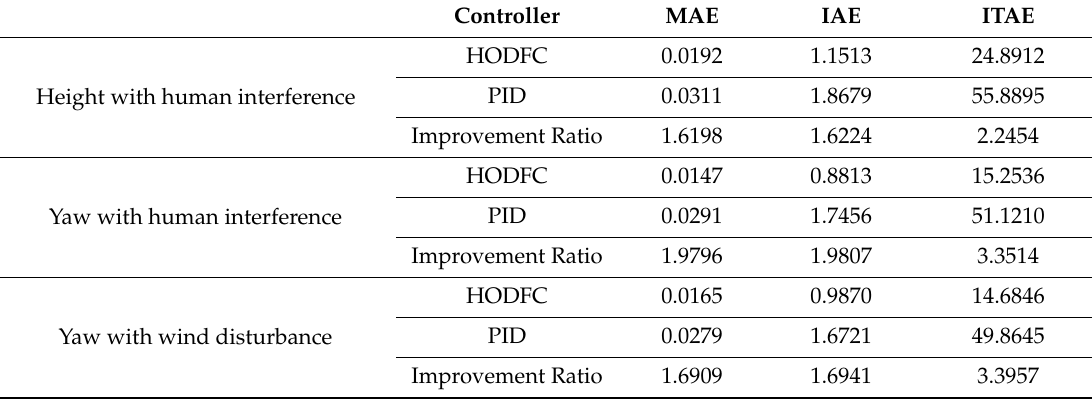
Table 5. Numerical performance metrics of static trajectory with